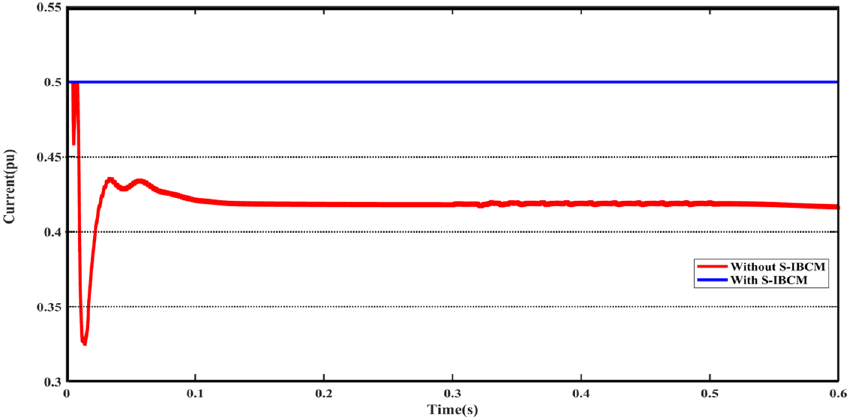
Figure 13. The open view of the DCMG terminal voltage with and without S-IBCM.